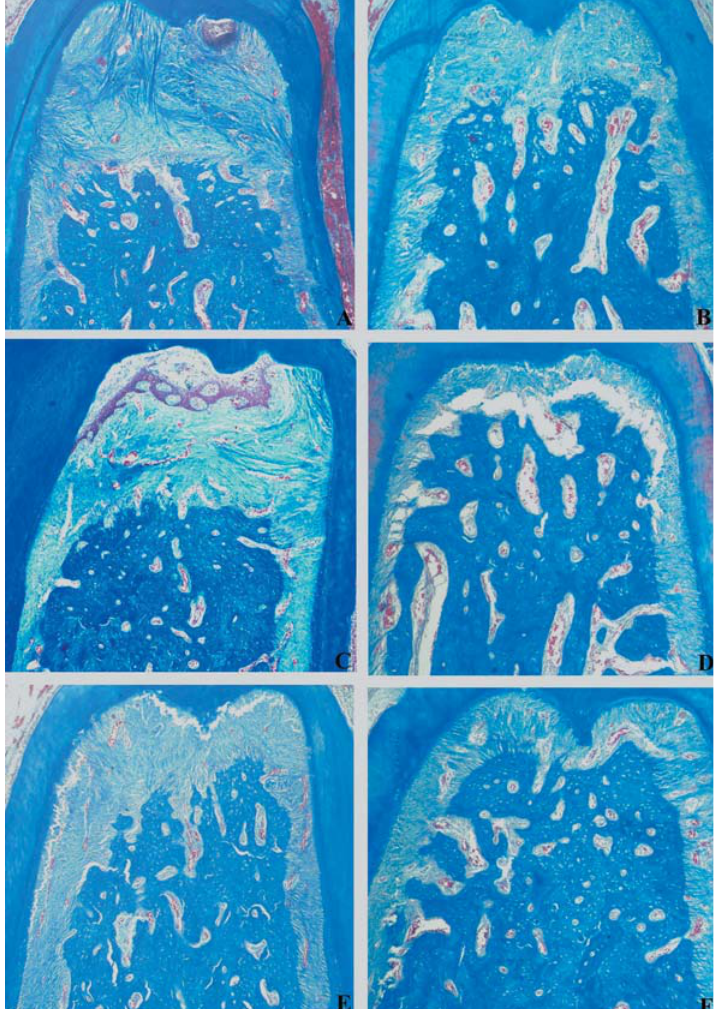
Figure 3- (cid:2)(cid:3)(cid:4)(cid:5)(cid:6)(cid:5)(cid:7)(cid:8)(cid:9)(cid:10)(cid:5)(cid:11)(cid:10)(cid:12)(cid:13)(cid:4)(cid:2)(cid:8)(cid:14)(cid:14)(cid:15)(cid:16)(cid:6)(cid:10)(cid:12)(cid:6)(cid:8)(cid:17)(cid:11)(cid:2)(cid:18)(cid:5)(cid:17)(cid:19)(cid:2)(cid:6)(cid:8)(cid:16)(cid:16)(cid:15)(cid:19)(cid:2)(cid:8)(cid:17)(cid:2)(cid:6)(cid:4)(cid:19)(cid:2)(cid:20)(cid:15)(cid:10)(cid:9)(cid:12)(cid:6)(cid:8)(cid:5)(cid:17)(cid:2)(cid:10)(cid:19)(cid:11)(cid:8)(cid:5)(cid:17)(cid:2)(cid:5)(cid:20)(cid:2)(cid:7)(cid:12)(cid:17)(cid:21)(cid:8)(cid:18)(cid:15)(cid:14)(cid:12)(cid:10)(cid:2)(cid:22)(cid:10)(cid:16)(cid:6)(cid:2)(cid:7)(cid:5)(cid:14)(cid:12)(cid:10)(cid:2)(cid:8)(cid:17)(cid:2)(cid:6)(cid:4)(cid:19)(cid:2)(cid:21)(cid:8)(cid:20)(cid:20)(cid:19)(cid:10)(cid:19)(cid:17)(cid:6)(cid:2)(cid:23)(cid:10)(cid:5)(cid:15)(cid:13)(cid:16)(cid:2)(cid:24)(cid:25)(cid:2) and T) and Periods (7, 15, 30 days): (A) Group C - 7 days; (B) Group T - 7 days; (C) Group C – 15 days; (D) Group T –